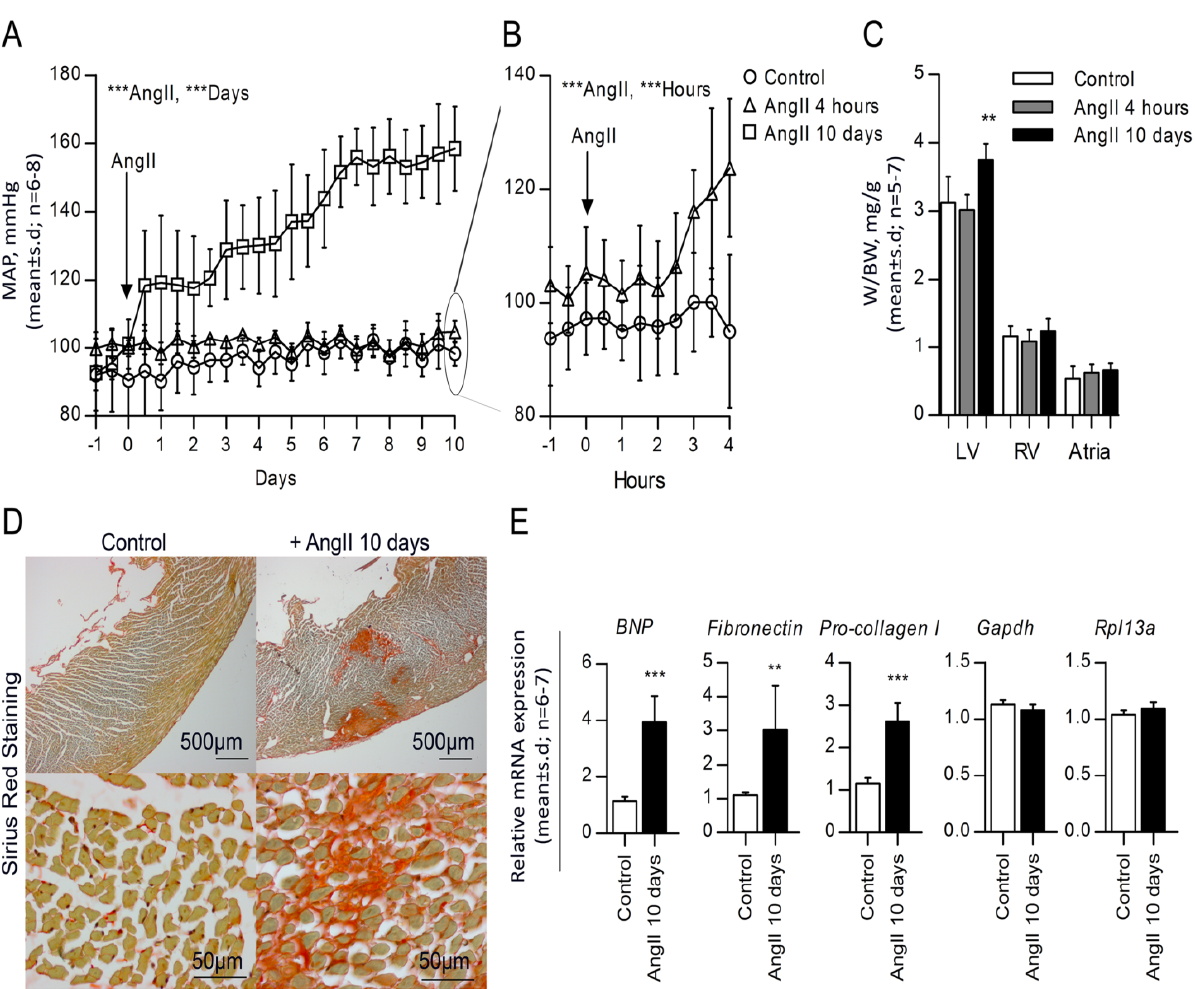
Figure 1. Characterization of AngII-induced hypertensive rat. ( A ) Mean daily averages of mean arterial blood pressure from seven rats treated with chronic infusion of 30 ng/kg/min AngII for 10 days ( □ ) and six rats treated with acute infusion of 30 ng/kg/min AngII for 4 h ( ∆ ), compared to eight control rats ( Ο ); ( B ) Mean hourly averages of mean arterial blood pressure from acute infusion of rats ( ∆ ) for four h compared to control rats ( Ο ). Data are shown as the mean ± SD. Arrows shows the start of AngII infusion (day 0). Statistical significance was tested by two-way ANOVA for either control versus AngII for 10 days or control versus AngII for 4 h. *** p < 0.001. A and B, duplicate figure [20]; ( C ) Weight to body weight ratio (mg/g) of chronic ( n = 7), acute ( n = 6) and control ( n = 8) rat hearts divided into left ventricle, right ventricle and atria. Data is presented as the mean ± SD, and statistical significance was tested by one-way ANOVA using Tukey’s multiple comparison test. ** p < 0.01; ( D ) Representative sections of left ventricles of AngII affected hearts compared to control hearts, stained with Sirius Red for collagen deposition; ( E ) qRT-PCR for the early marker of hypertrophy, BNP, the fibrotic markers, Fibronectin and Procollagen-I , and the two stably expressed reference genes, Gapdh and Rpl13a (M: 0.140 and CV: 0.049). Data is presented as the mean ± SD, and statistical significance was tested by un-paired t -test. * p < 0.05, ** p < 0.01 and *** p <